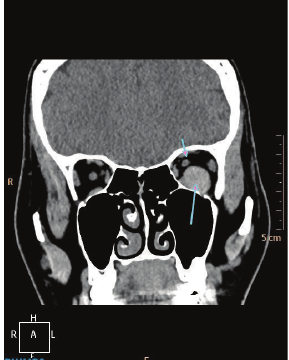
Figure 3: Coronal T1 weighted MR image showing hypointense haematoma (long arrow) and superomedially displaced left optic nerve (short arrow).